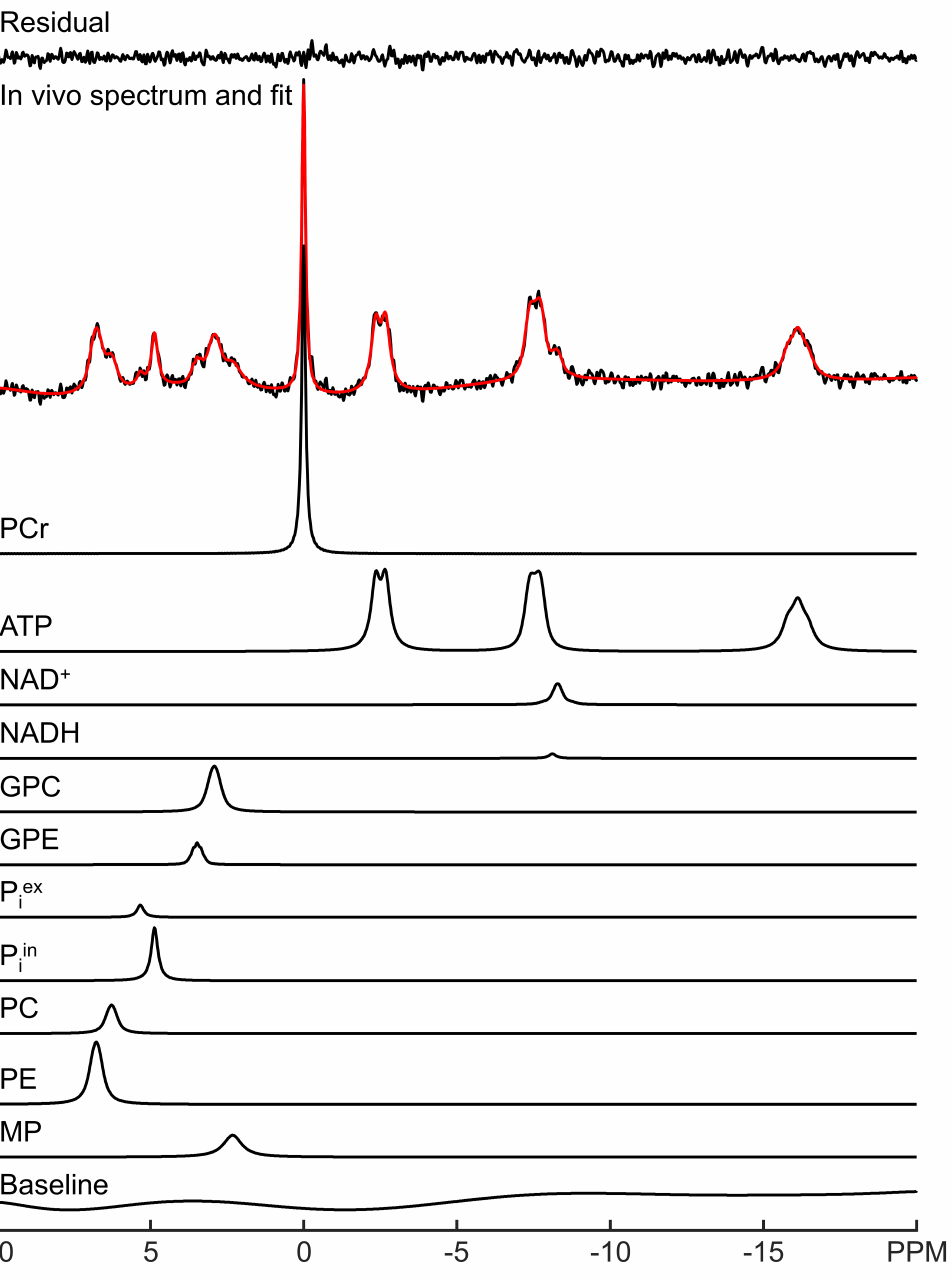
Figure 1. LCM fitting of a representative in vivo 31 P MRS spectrum acquired from human brain at 3 Tesla. The fit (red) and fit residual covering − 20 to 10 ppm are shown, along with fitted individual metabolites and the background spectral